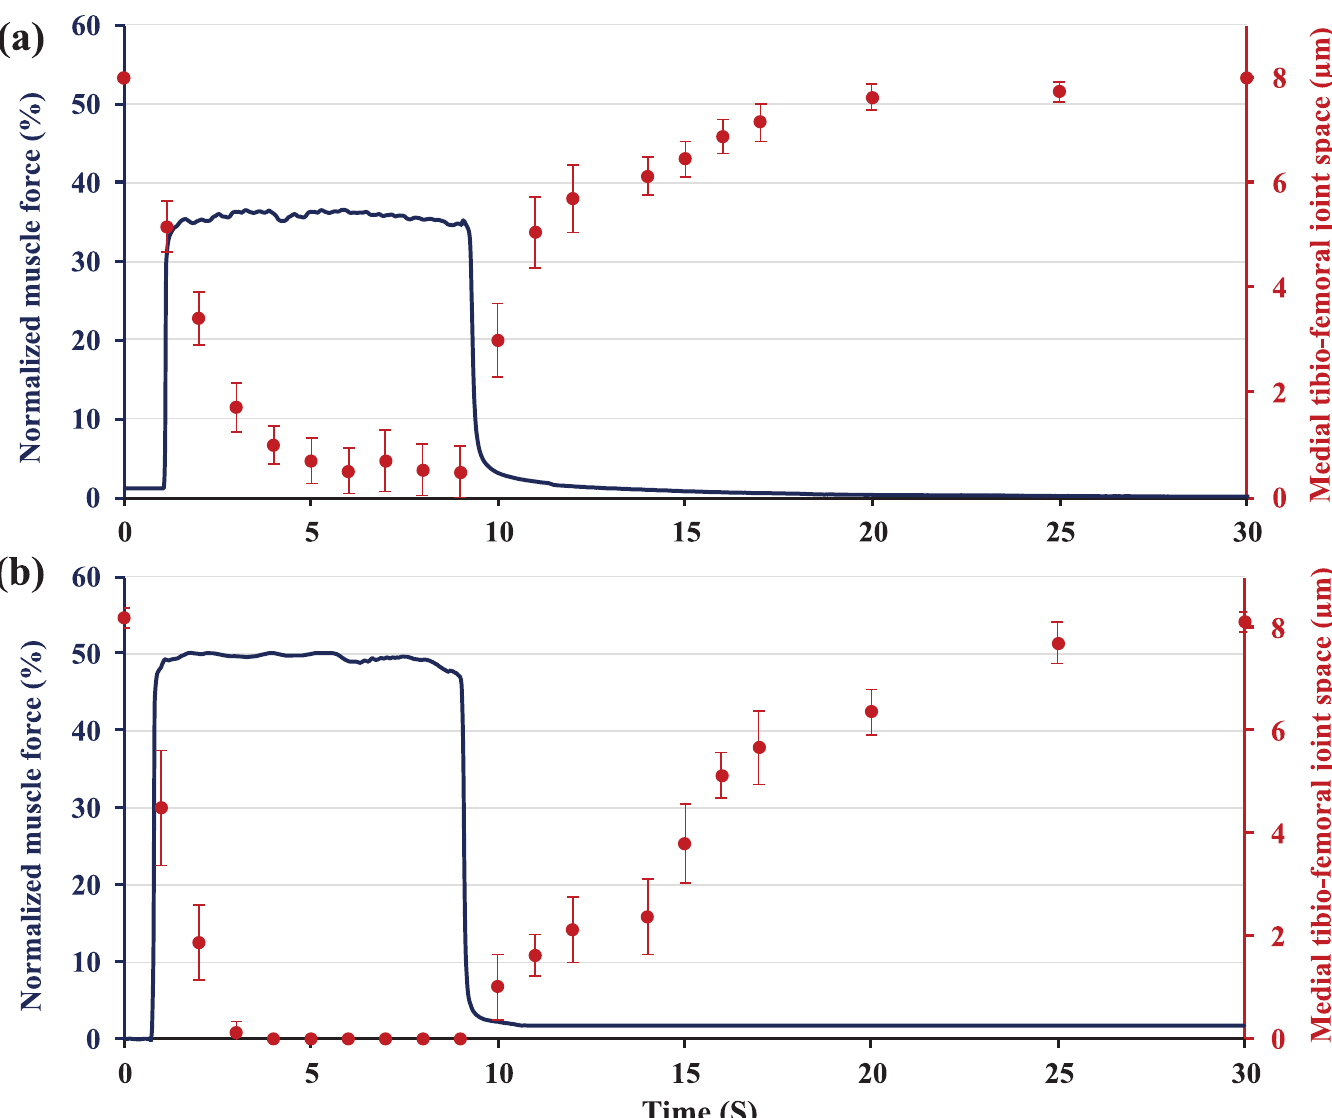
Fig 2. Normalized (relative to maximum = 100%) knee extensor forces as a function of time. The medial tibio-femoral joint space narrowed during loading with (a) 35% of muscular loading (n = 7), the two cartilage surfaces never touch and no sign of cartilage deformation was noticed at this force. (b) 50% of muscular loading (n = 7), the cartilage-on-cartilage space reached zero and cartilage thickness decreased for these loading conditions. In both cases, medial tibio-femoral cartilage-on-cartilage space returned back to its original position in ~20s following the removal of force.